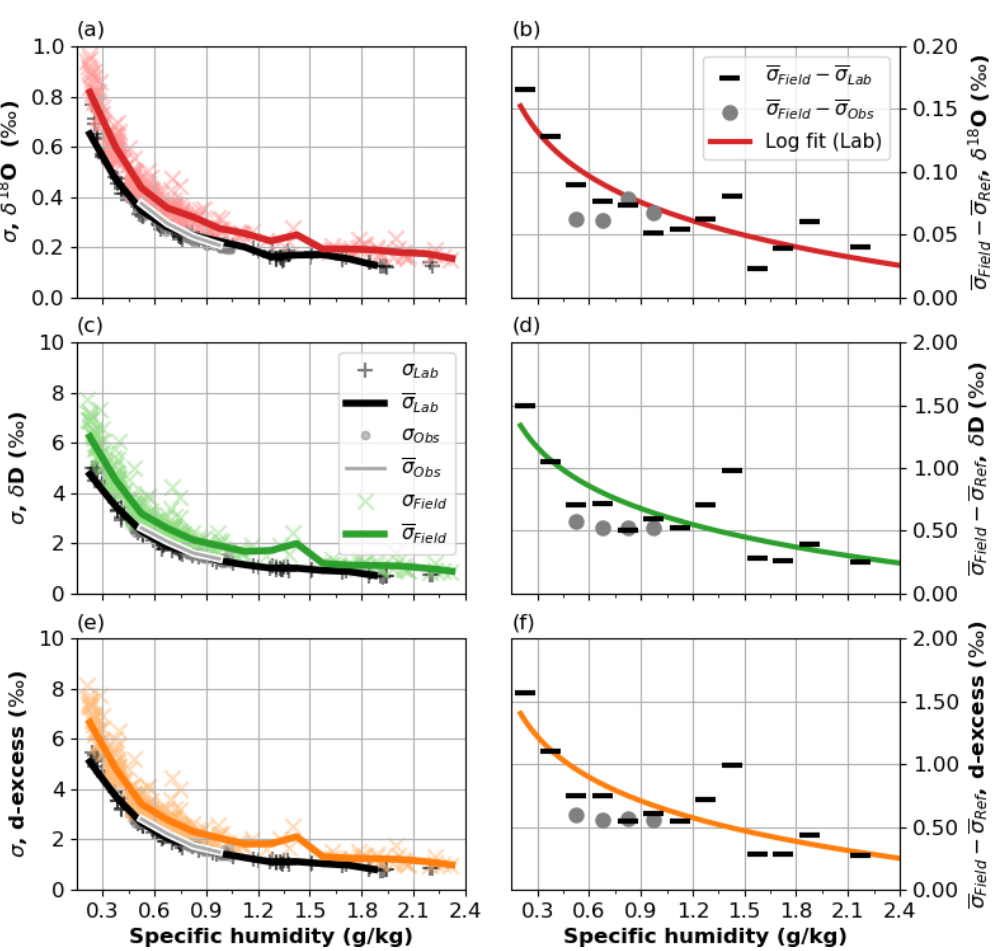
Figure 7. Standard deviations of δ 18 O, δ D and d-excess in field and reference periods, alongside differences between periods. Measurements organized across 0.15gkg − 1 bins, from 0.15 to 2.40gkg − 1 . (a) Standard deviations of δ 18 O over 5min periods from field (colored “x”), laboratory (black “ + ”) and observatory (gray “o”); see text for details. Bin means depicted with thick lines. (b) Differences between bins means from field and laboratory (black ticks) and field and observatory (gray circles) periods. Thick colored line indicates the logarithmic fit of field–lab differences. (c, d) Same as panels (a) and (b) but for δ D. (e, f) Same as panels (a) and (b) but for